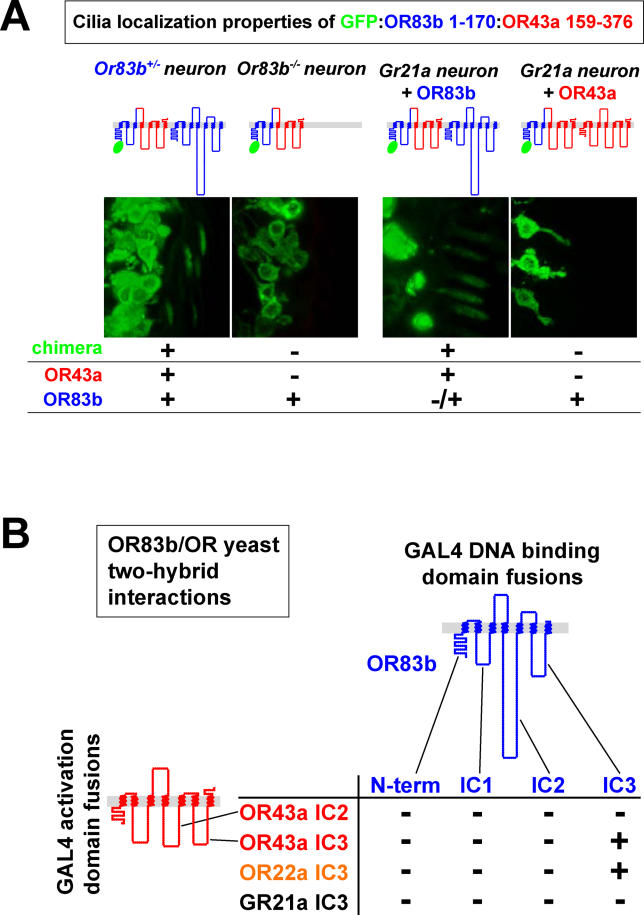
OR83b and ORs Associate via Conserved C-Terminal Domains(A) Top rows: Immunostaining of the GFP:OR83b(1–170):OR43a(159–376) chimera (α-GFP, green) in antennal sections of animals of the following genotypes (left to right): Or83b+/− neuron [Or83b-Gal4/UAS-GFP:Or83b(1–170):Or43a(159–376);Or83b1/+]; Or83b−/− neuron [Or83b-Gal4/UAS-GFP:Or83b(1–170):Or43a(159–376);Or83b1/Or83b2]; Gr21a neuron + OR83b [Gr21a-Gal4/UAS-GFP:Or83b(1–170):Or43a(159–376);UAS-Or83b/+]; Gr21a neuron + OR43a [Gr21a-Gal4/UAS-GFP:Or83b(1–170):Or43a(159–376);UAS-Rho:Or43a/+]. Bottom table: summary of localization (+) or no localization (−) to cilia of the chimera and, for comparison, OR83b and OR43a.(B) Interactions between OR83b and OR cytoplasmic domains detected by the yeast two-hybrid assay by observation of growth (+) or no growth (−) of yeast co-transformed with the indicated bait/prey combinations on media selecting for expression of HIS3 and ADE2 reporters.